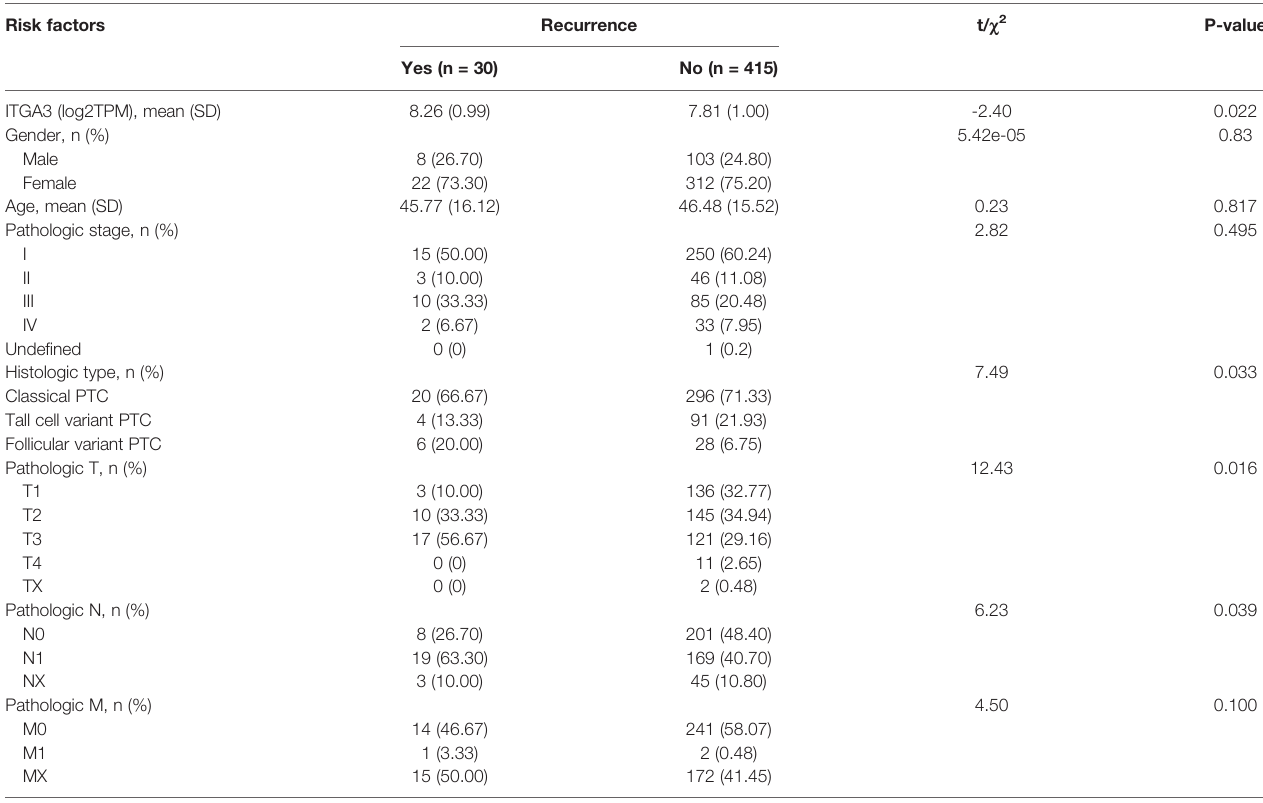
TABLE 2 | Univariate analysis for PTC recurrence in the cohort of TCGA data. Risk factors